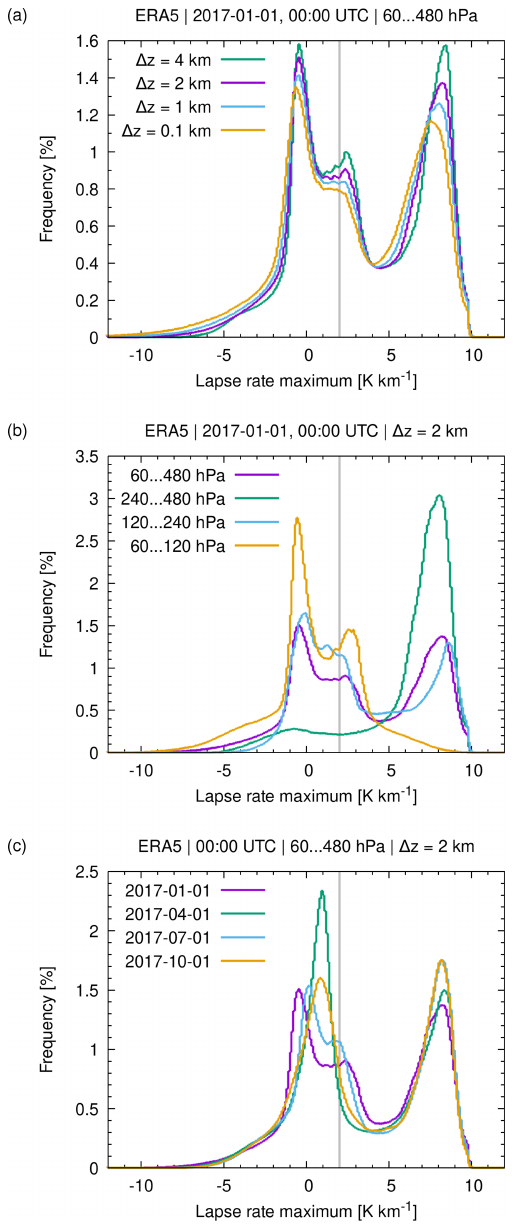
Figure 14. Maximum lapse rate statistics from the middle tropo- sphere to the lower stratosphere from ERA5 data (a) for differ- ent vertical layer depths (cid:49)z , (b) for different pressure ranges, and (c) on different days. The gray line indicates the 2Kkm − 1 lapse rate threshold of the WMO